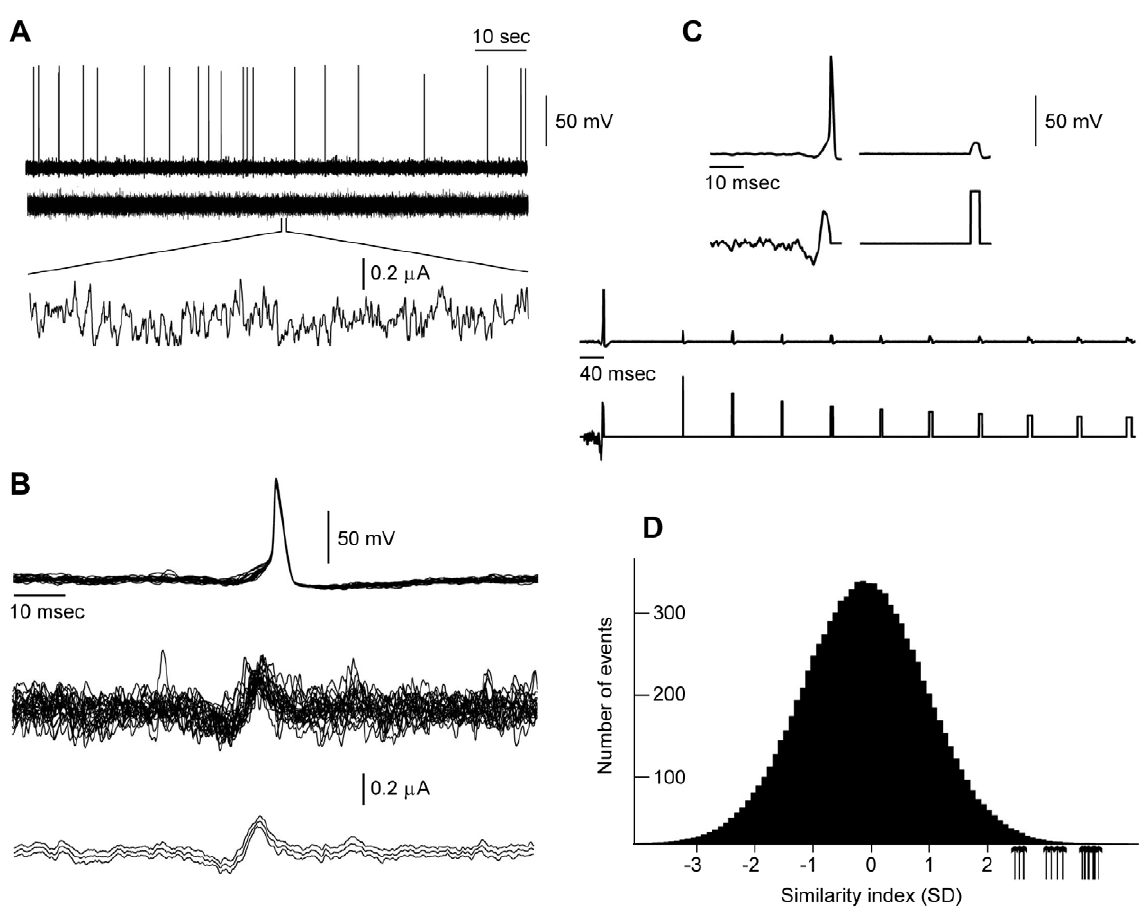
Figure 3. An example of a search for stimulus shapes that optimally excite the squid giant axon preparation using the stochastic approach described in the text. These results are all from a single axon. Similar results were observed in all other axons. A ) The axon was stimulated with a stochastically varying time series consisting of modeled excitatory and inhibitory post-synaptic currents (PSCs), as described in the text. Shown is a stimulation trial of 100 seconds consisting of balanced excitatory and inhibitory PSCs (zero mean current) having a mean Poisson rate of 1 msec 2 1 . Each PSC had a decay constant of 1 msec. The stimulation amplitude (RMS) was set to a level that produced rare action potentials ( , 1 Hz). B ) All twenty-one action potentials from the trial were superimposed by aligning their peak voltages, i.e., the maximum overshoot potential. The corresponding input currents were similarly aligned (middle tracing). The bottom panel illustrates the mean ( 6 2 SEM) of the stimulus currents. This spike-triggered average is the candidate optimal stimulus shape. C ) The candidate optimal stimulus from B elicited an action potential when it was administered to the axon (first tracing with the stimulus shown below the action potential response). The stimulus is the same as in the bottom panel of B . A rectangular depolarizing current pulse having the same RMS current as the optimal stimulus failed to elicit an action potential (top tracing to the right of the action potential). Rectangular pulses having durations ranging from 1 to 10 msec with the same RMS current as the optimal stimulus failed to elicit action potentials (bottom two tracings). D ) Histogram generated by convolving the optimal stimulus in B with the raw stimulus in A , as described in the text. This convolution measures how similar the optimal is to any 20 msec portion of the input signal ( A , tracings below the action potentials elicited by the input). We refer to this as similarity index. This parameter is measured in units of standard deviations (SD) from the mean. Action potentials were seen only when this measure was . 2 SD above the mean as indicated by the arrows showing that stimuli that elicited action potentials were highly similar in shape to the